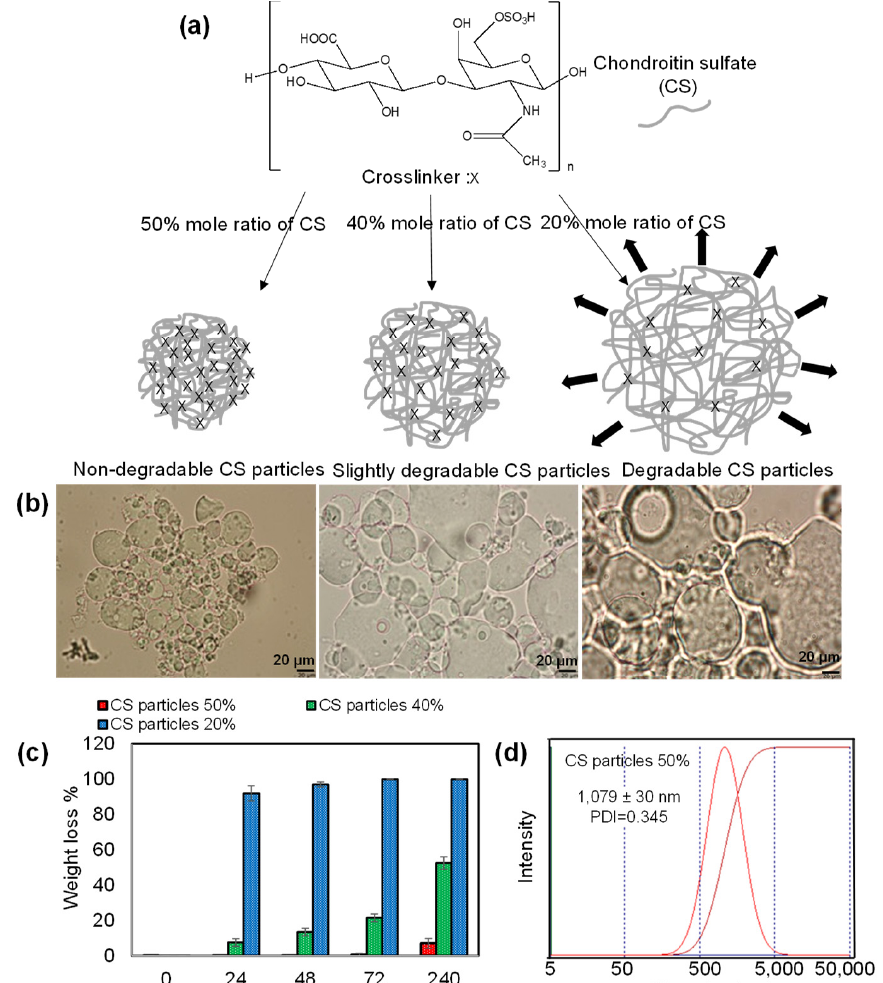
Figure 1. ( a ) Schematic representation of non-degradable, slightly degradable, and completely degradable CS particles prepared using three mole ratios of DVS crosslinker at 50, 40, and 20 mole% of CS repeating unit, and ( b ) their optical microscope images, and ( c ) weight loss% of CS particles prepared at 50, 40, and 20% crosslinked mole ratios were incubated for 24 h, 48 h, 72 h, and 240 h in physiological conditions at pH 7.4 and 37 °C. ( d ) Hydrodynamic size distribution of CS particles crosslinked at 50% mole ratio.